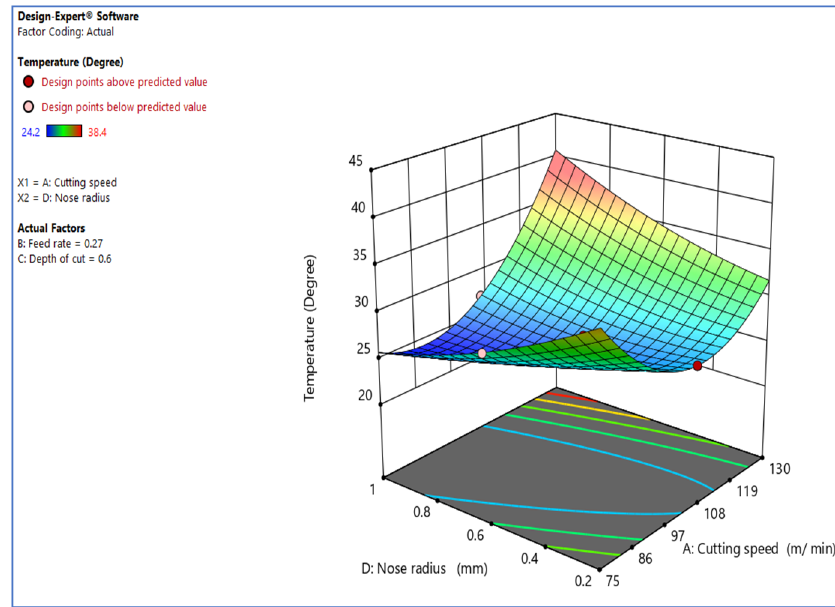
Figure 4. Inter. effect of V c vs. R n over temp.